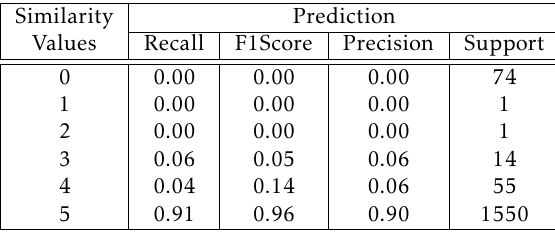
Table 6. Replaceability Outcomes of Existing Prototype Similarity